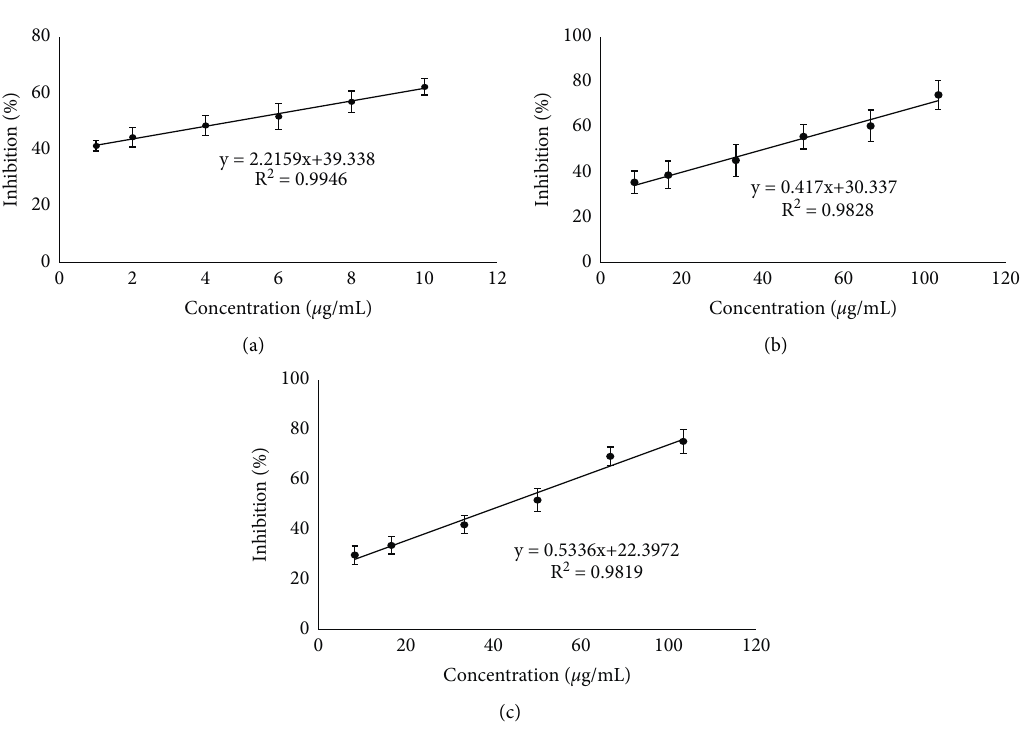
Figure 5: The alpha amylase inhibition of (a) acarbose, with IC 50 value of 4.81 ± 0.34 μ g/mL; (b) R . tuberosa (L) extract, with IC 50 value of 47.15 ± 4.77 μ g/mL; and (c) microcapsules of R . tuberosa (L.) extract prepared in pH 4, 0.1% (w/v) chitosan concentration and 90min stirring time, with IC 50 value of 50.65 ± 9.17 μ g/mL.